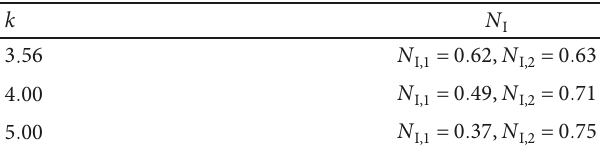
with di ff erent k . I